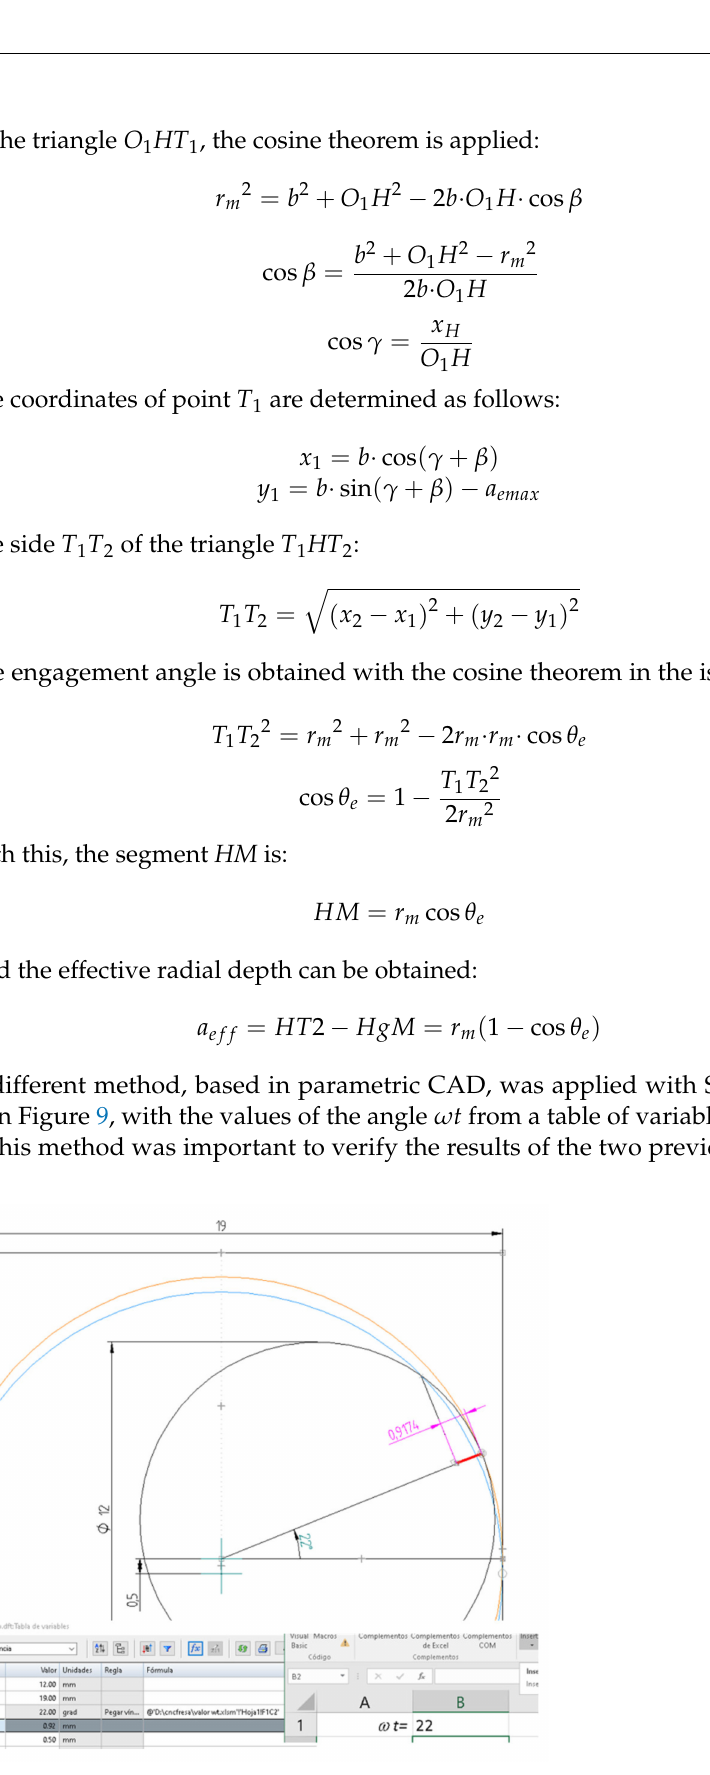
Figure 9. Graphical method to verify a eff